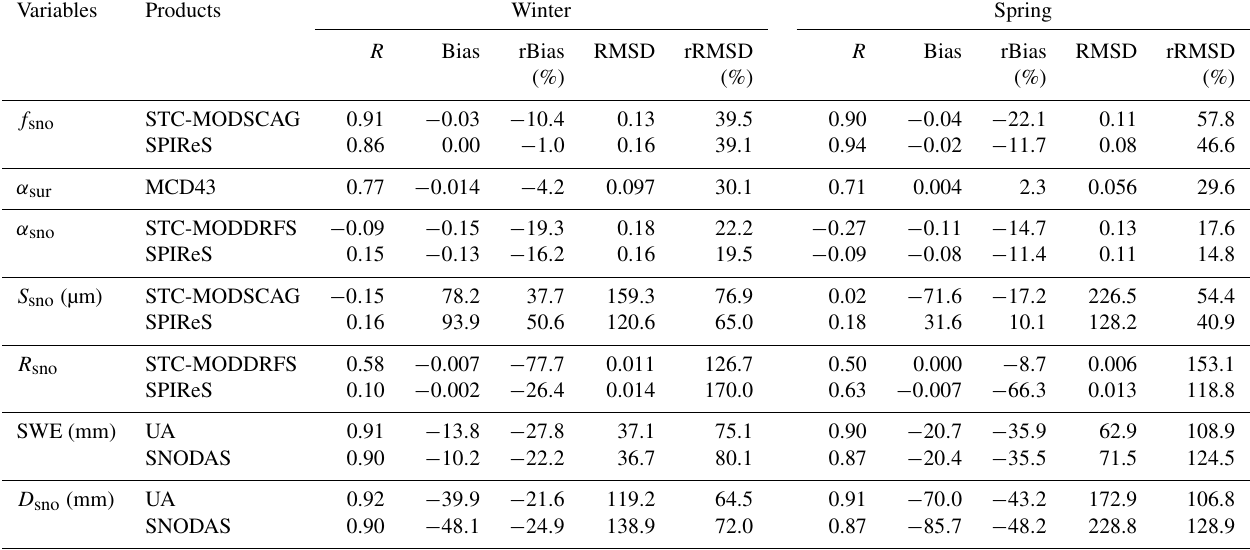
Figure 3. Spatial distributions of (a, b) snow cover fraction ( f sno ) in ELM, and (c, d, g, h) the f sno difference between ELM and two remote sensing products (i.e., STC-MODSCAG and SPIReS) and (e, f, i, j) their temporal correlations ( R s ) for different seasons: (a, c, e, g, i) winter and (b, d, f, h, j) spring. In all panels, regions with no snow cover are masked with white color. The area-weighted average values are labeled in each panel. Table 2. Evaluation of snow properties in ELM against two remote sensing products (STC-MODSCAG/STC-MODDRFS and SPIReS) and two data assimilation products (UA and SNODAS) for winter and spring. Here, the snow properties include snow cover fraction ( f sno ), surface albedo ( α sur ), snow albedo ( α sno ), snow grain size ( S sno ), snow albedo reduction ( R sno ), snow water equivalent (SWE), and snow depth ( D sno ). The statistical metrics were calculated using the data over the WUS, except that those against STC-MODSCAG/STC- MODDRFS in winter were calculated using the data over the WUS regions below 42 ◦ in latitude.